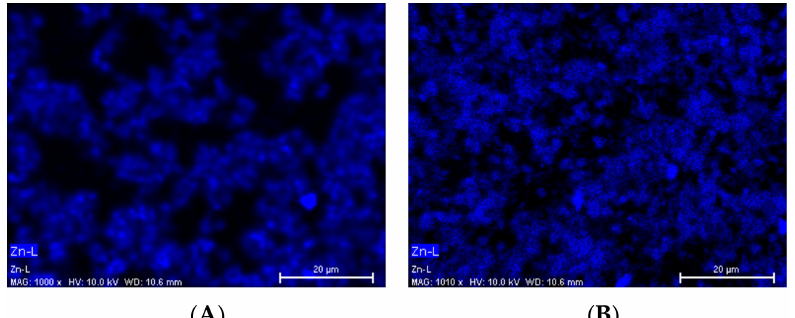
Figure 6. EDX analyses of Pebax/ZIF-8 ( A ) and Pebax/PEG/ZIF-8 ( B ) membranes. ZIF-8 amount is 7 wt%. Blue color is Zn element.